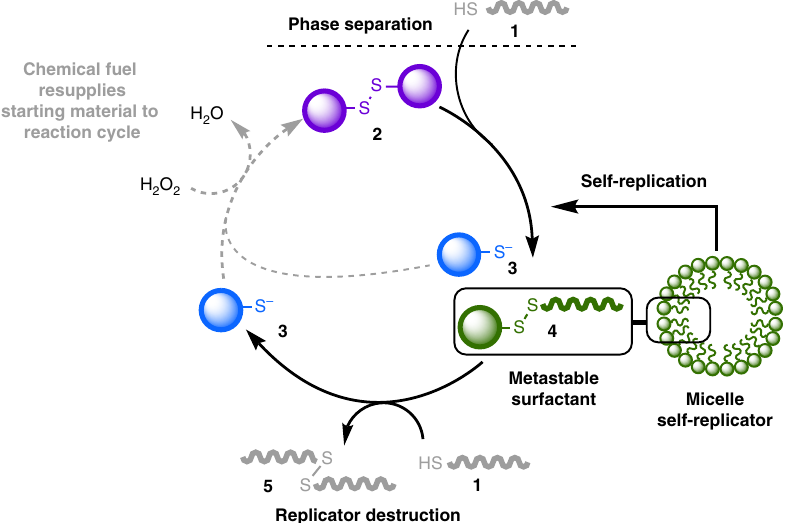
Fig. 2 The substrate cycle of a chemically fuelled self-replicator. Reaction between phase-separated components 1 and 2 is slow and forms thermodynamic waste product 3 and surfactant 4 . Aggregation of 4 into micelles increases phase mixing and the rate of reaction to form additional 4 so that surfactant formation is autocatalytic and the supramolecular aggregates self-replicating. Destruction of 4 by a second thiol-disul fi de exchange forms additional waste 3 and 5 . At equilibrium, in a closed system (solid arrows), the surfactant 4 is destroyed. However addition of an oxidising fuel (dashed grey arrows) regenerates starting disul fi de 2 from waste 3 and allows the replicator population to be maintained and function as a replicator in an out-of-equilibrium state. At the steady state successive cycles consume both oxidising fuel and thiol 1 whilst intermediates 2 , 3 and 4 remain at the same concentration — this is similar to substrate cycles observed in biological systems 39,40 . Once fuel supply is halted the replicator stops being re-formed and the system degrades to